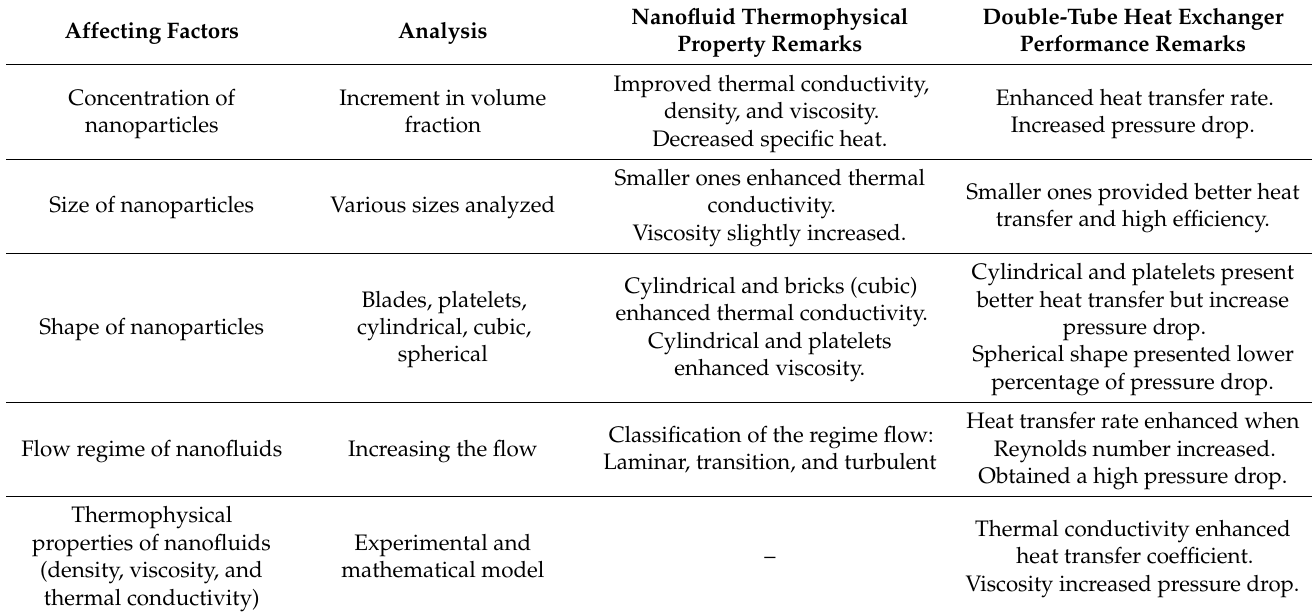
Table 8. Overall summary of analysis of factors influencing nanofluid thermophysical properties and double-tube heat exchanger